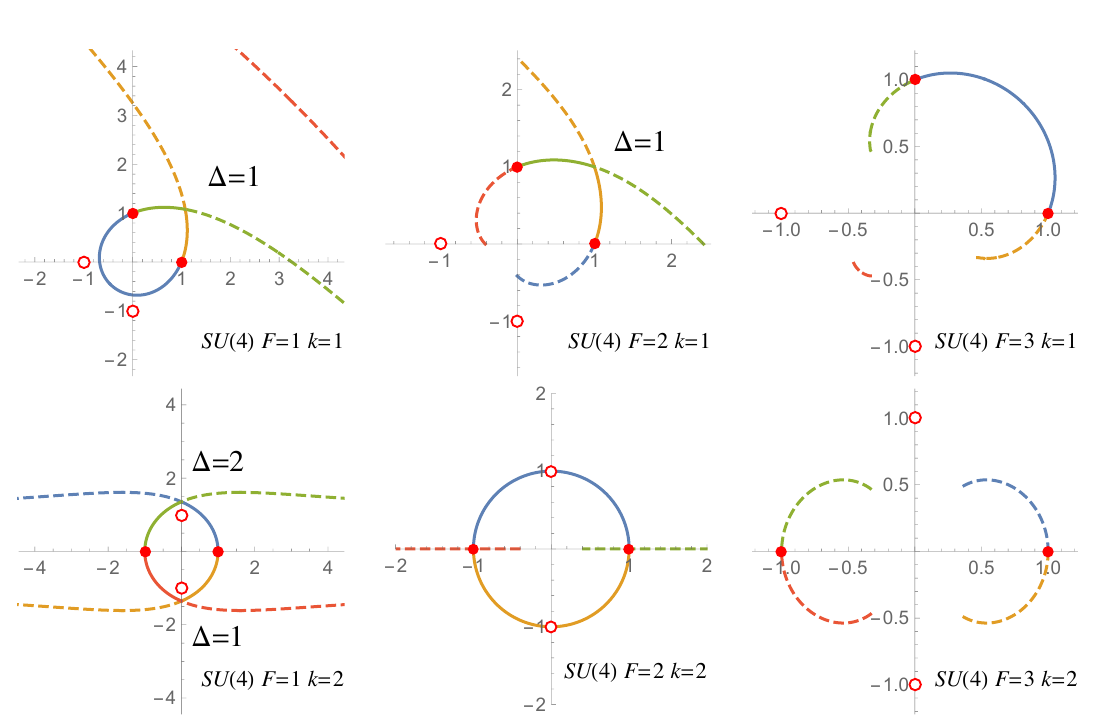
Figure 3: Symmetry preserving k -walls in massive SU ( 4 ) SQCD with F = 1,2,3 flavors. Conventions are the same as in Figure